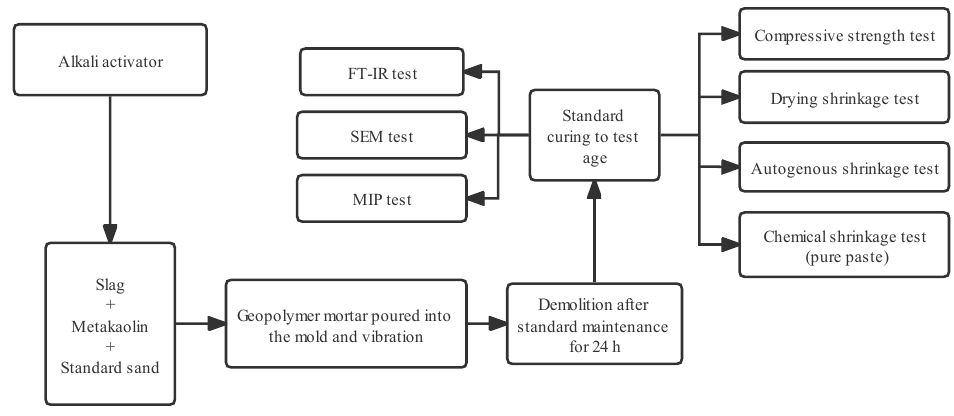
Figure 2. Test process flowchart.